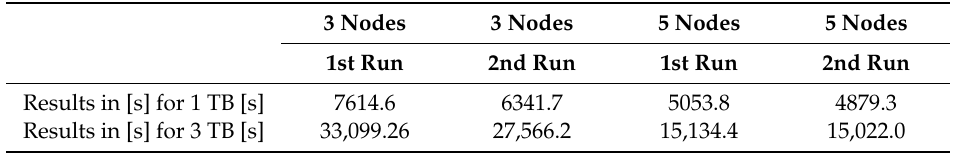
Table 4. Summary of TPC-H queries on three and five nodes configurations in the first and second runs on 1 TB and 3 TB test